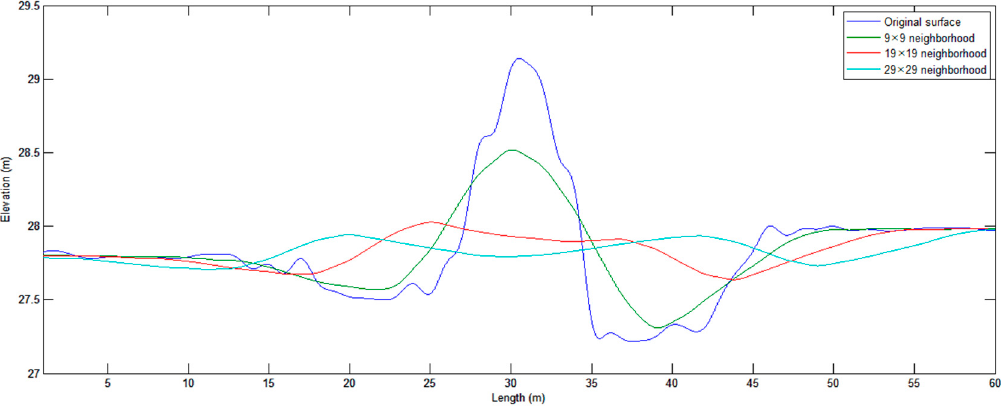
Figure 5. Defining neighborhood size when smoothing.